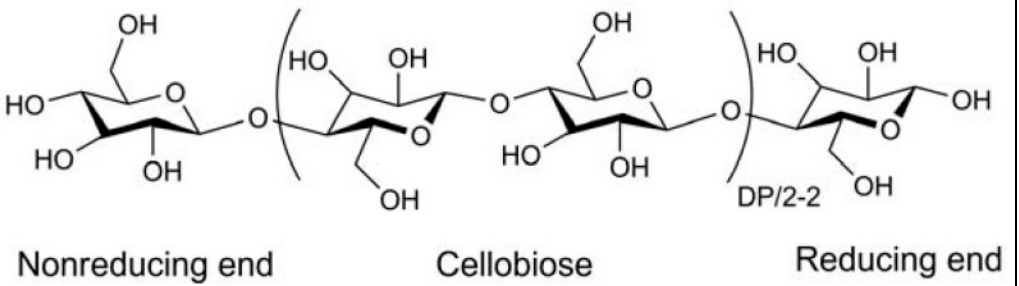
Figure 1. Structure of cellulose reprinted with permission from ref. [24]. Copyright 2010 American Chemical Society.